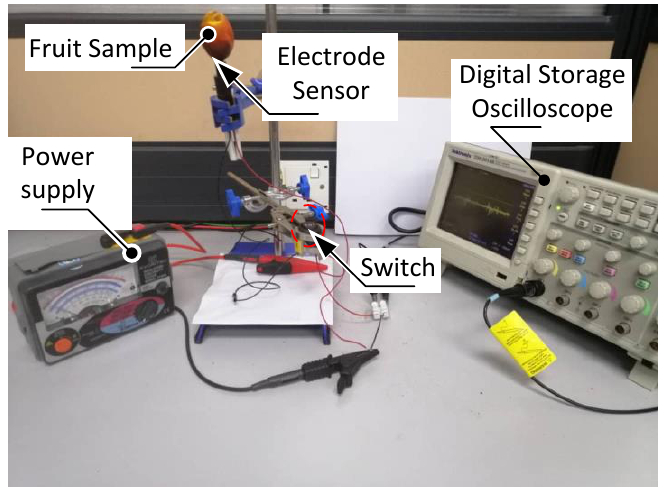
Figure 5. Photograph of experimental setup.